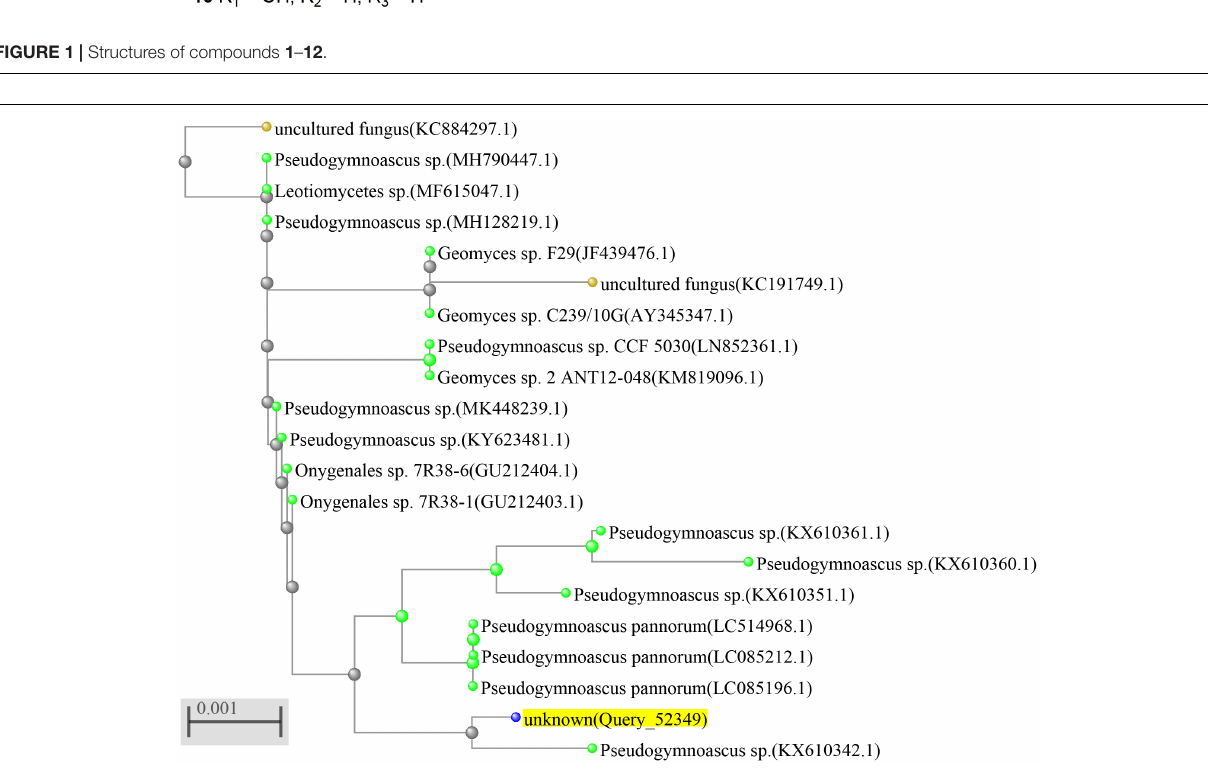
a Pseudogymnoascus sp. ( Figure 2 ), with GenBank (NCBI) accession number